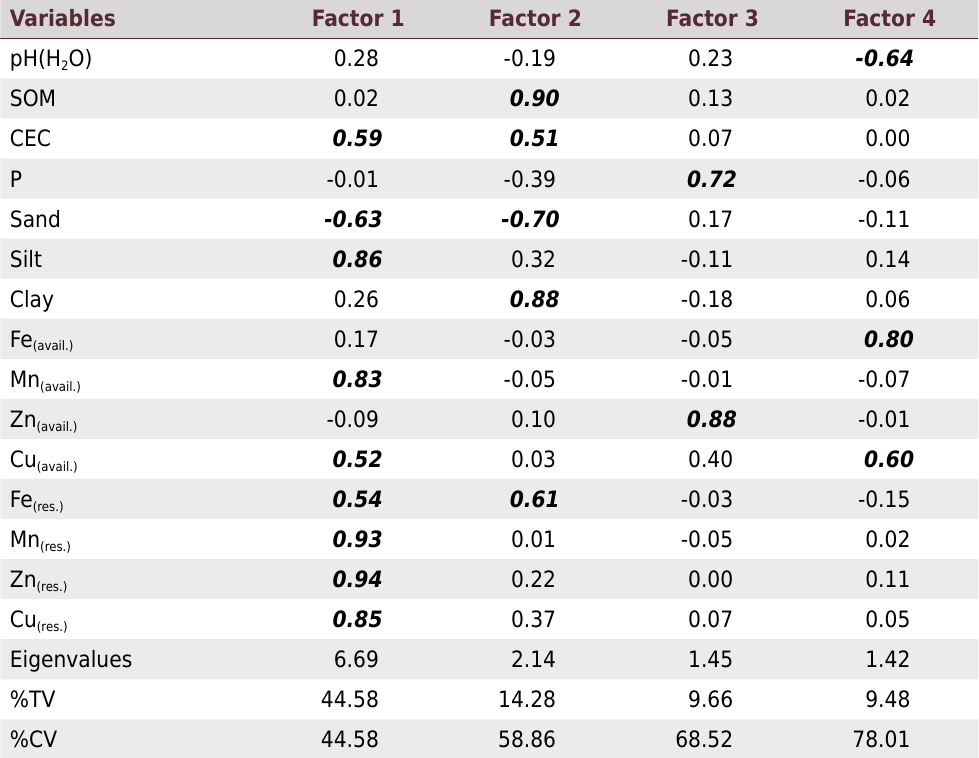
Table 2. Total explained and rotated factorial matrix for micronutrients in soil cultivated with sugarcane